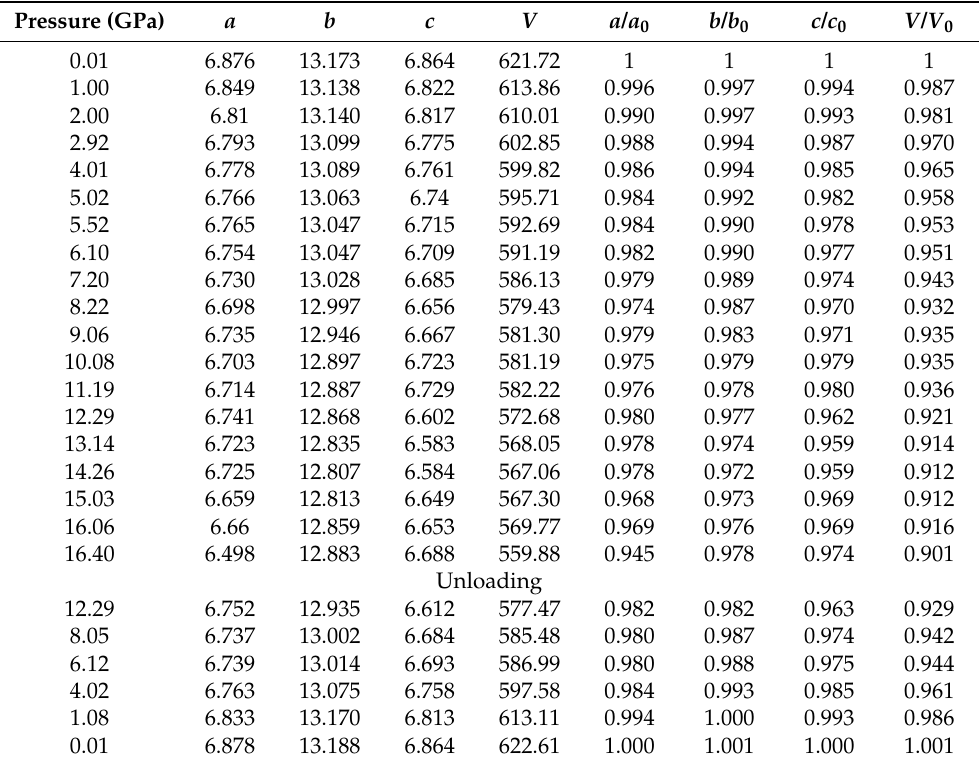
Table 4. The unit cell parameters, molar volume and their normalized ratios of scottyite in the loading and unloading